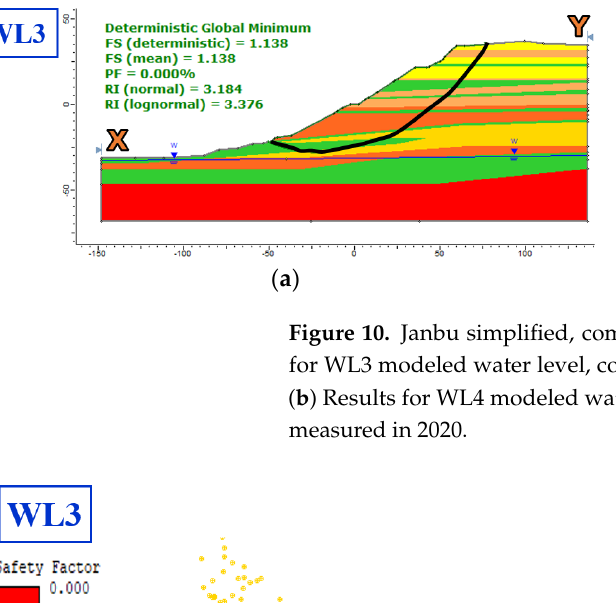
Figure 9. Probability of failure (POF) by Bishop and Janbu simplified methods for different modeled water levels.